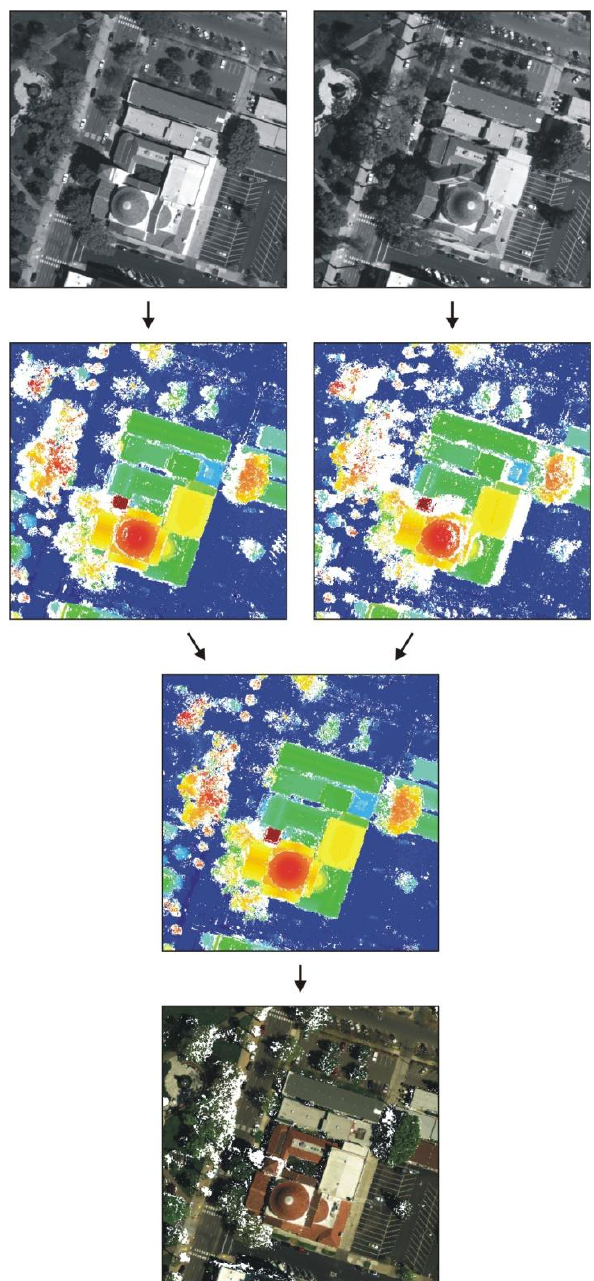
Figure 3: SGM processing workflow with disparity merge. Top: ADS backward (left) and forward (right) panchromatic images. Below: color-encoded disparity maps based on nadir/backward (left) and nadir/forward image matching (right); stereo pair merge in disparity space, with most occlusions and gaps filled. Bottom: final RGB colored info cloud in true ortho view.